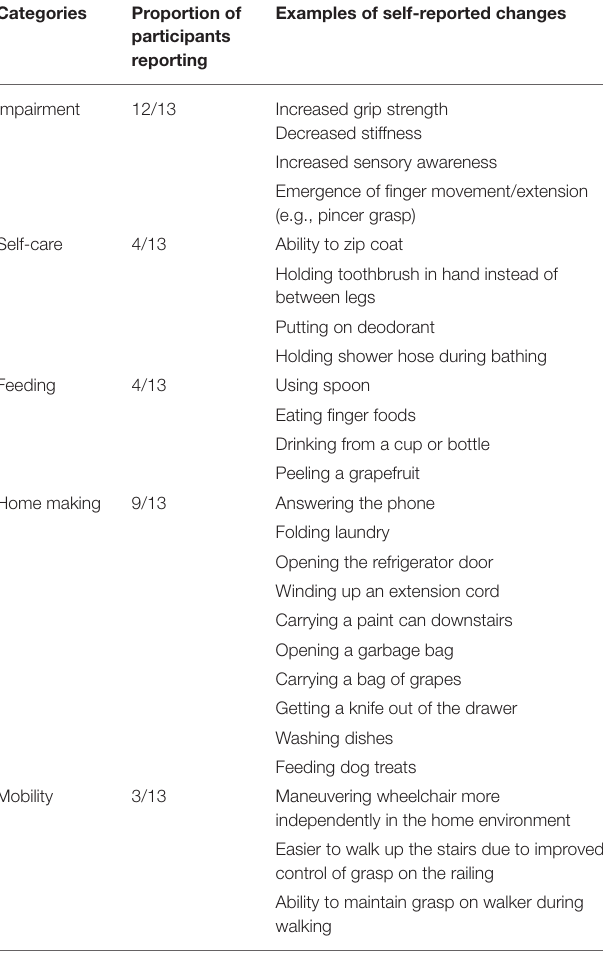
TABLE 5 | Self-reported improvements in arm impairment and functional use.